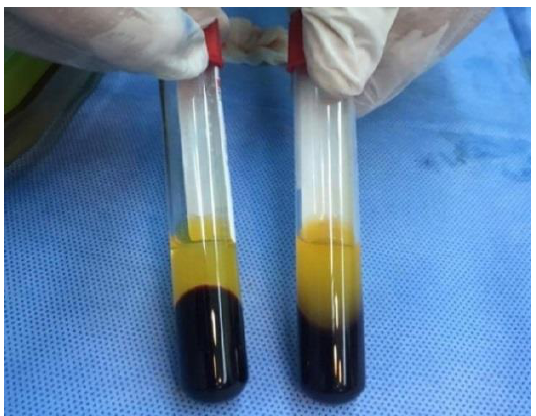
Figure (1): Identical PRF clot obtained from 10ml of blood (5 ml for each tube).